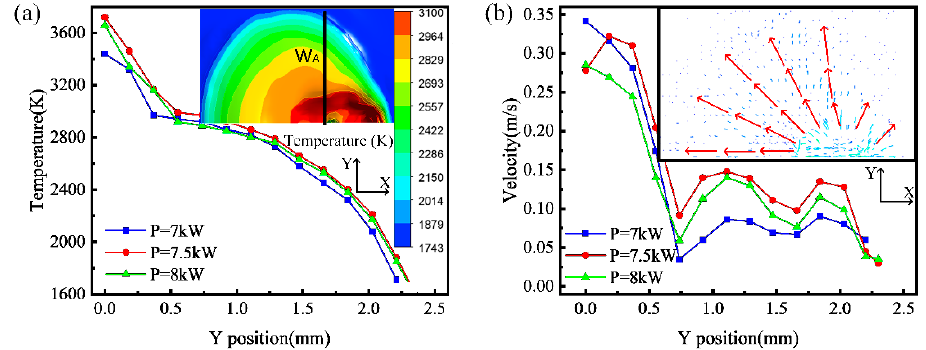
Figure 10. At simulated 35 ms: ( a ) Temperature of WA line, ( b ) speed of WA line.